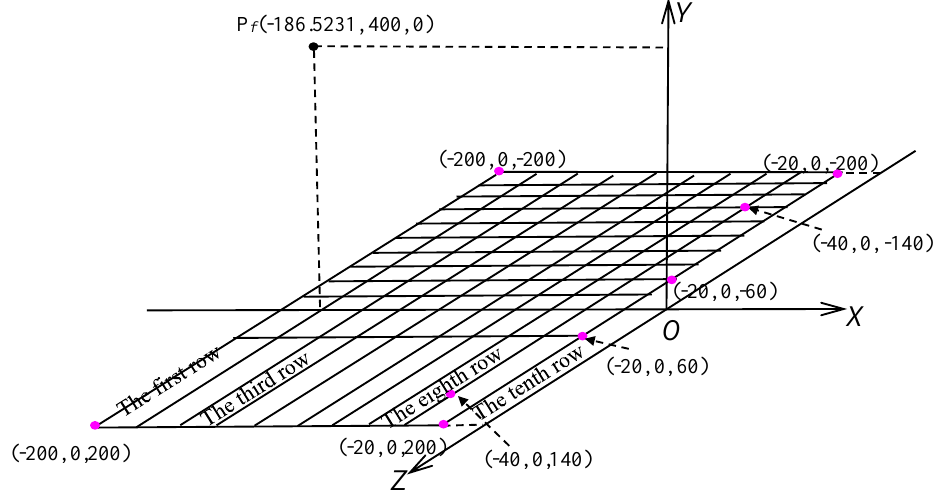
Figure 7. The schematic diagram for vertex positions of aspheric reflectors in the coordinate system (in units of cm).